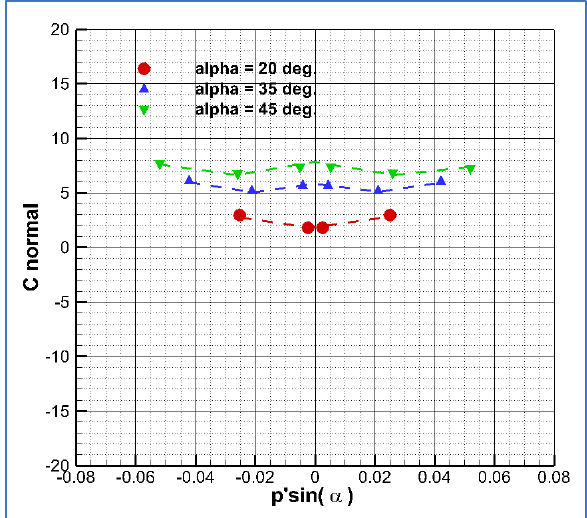
Figure 16. Normal force coefficient versus reduced roll rate and angle of attack. Ma = 0.2, Re =2 × 10 6 and three angles of attack.